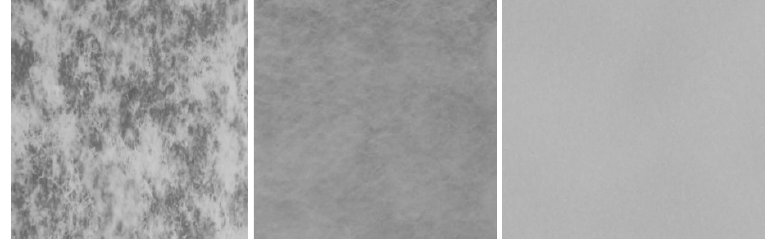
Figure 5. Dispersion image of PBO